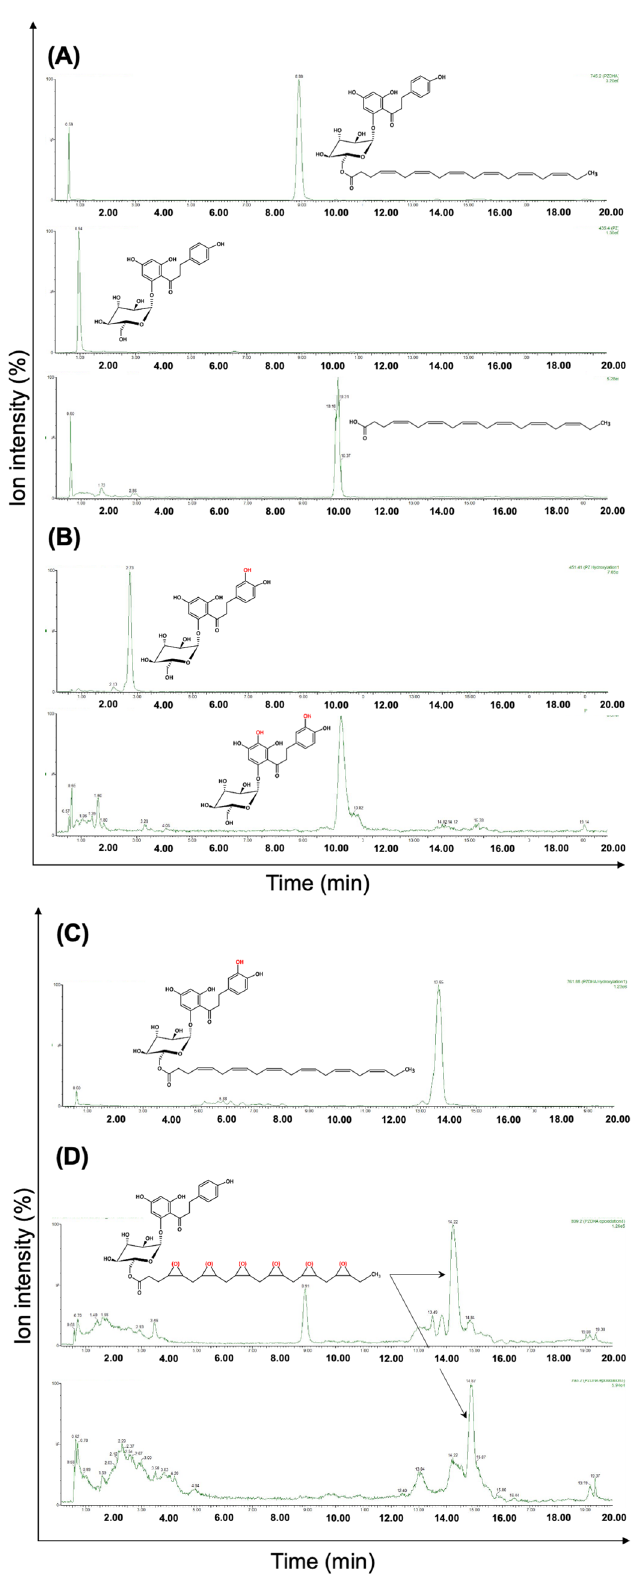
Figure 2. PZ-DHA undergoes phase I metabolism in the presence of freshly prepared mouse liver microsomes. PZ-DHA (1.1 µM) was incubated with 100 mM NADPH in the presence of mouse liver microsome for 1 h at 37 °C. Metabolites from PZ-DHA (A) hydrolysis, (B) and (C) hydroxylation, and (D) epoxidation were